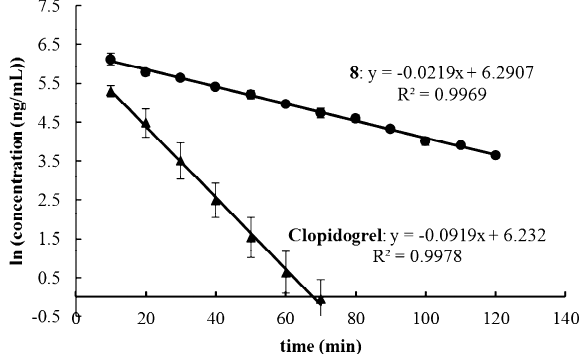
Figure 2. First order decomposition of clopidogrel and clopidogrel- d 3 ( 8 ) in rat whole blood in vitro . Data are means ± SD, n = 3, for reactions at 37 °C and an initial concentration of 1000 ng/mL.